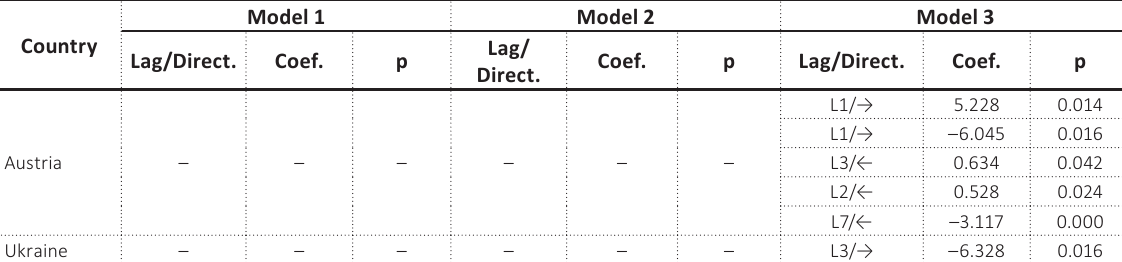
Table 12. VAR analysis for the case of Ukraine and Austria